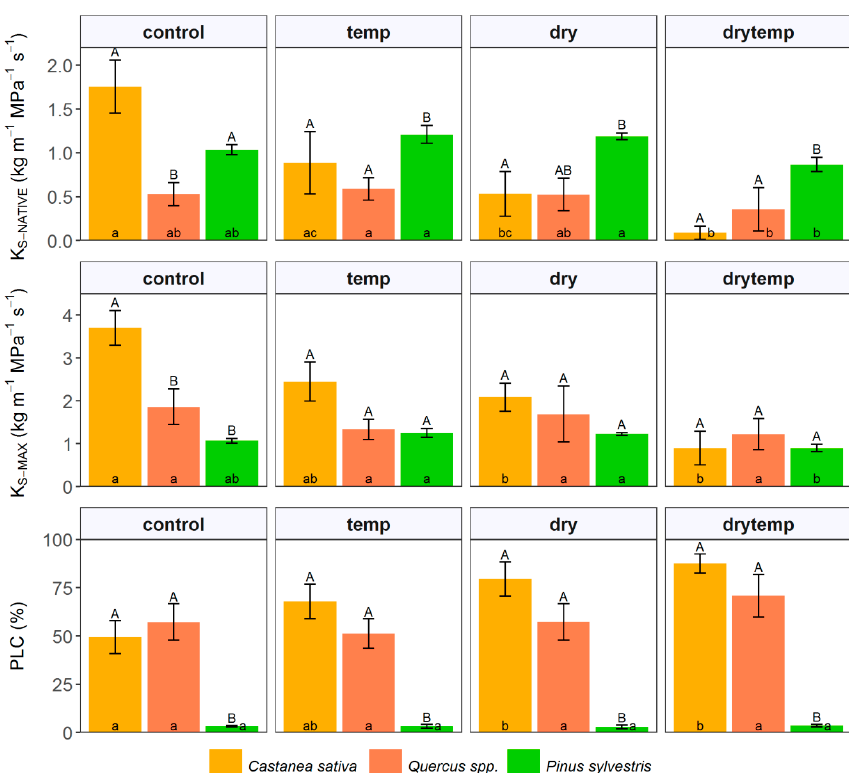
Figure 6. Native specific-hydraulic conductivity K S-NATIVE , maximum specific-hydraulic conductivity K S-MAX and percentage of loss of hydraulic conductivity PLC of the study species under the four treatments. Bars represent means and their standard errors. Upper and lowercase letters represent inter- and intraspecific significant differences ( p < 0.05) within and between treatments, respectively.